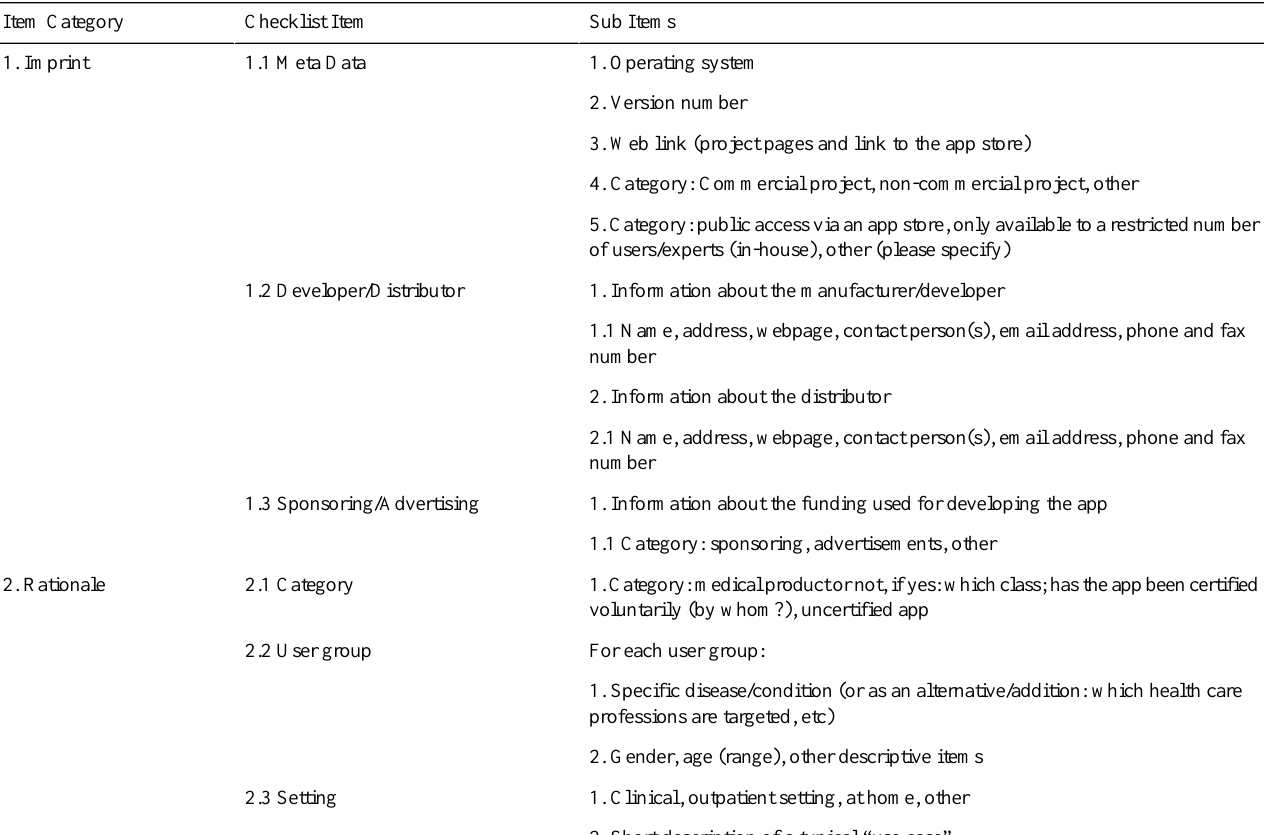
Table 2. Detailed description of items of the App-Synopsis for health apps and medical apps.